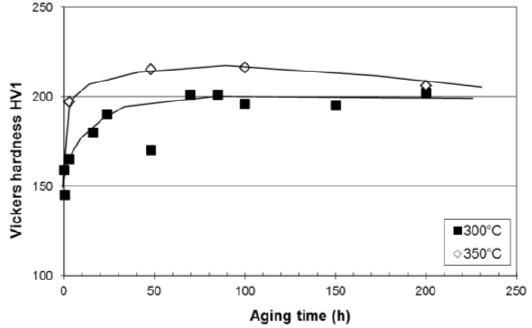
Figure 8. Hardness evolution of swaged CuNi3Si1Mg during thermal exposure at 300 °C (specimens swaged from 5.3 to 2.7 mm diameter).